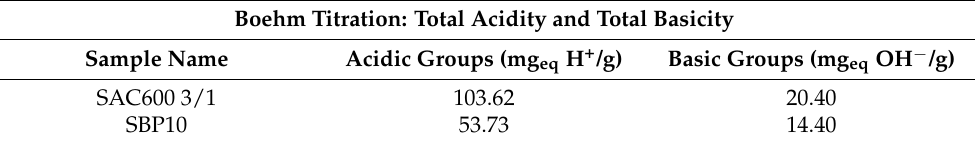
Table 2. Total acidity and total basicity for lab-scale and pilot-scale Sargassum activated carbons.